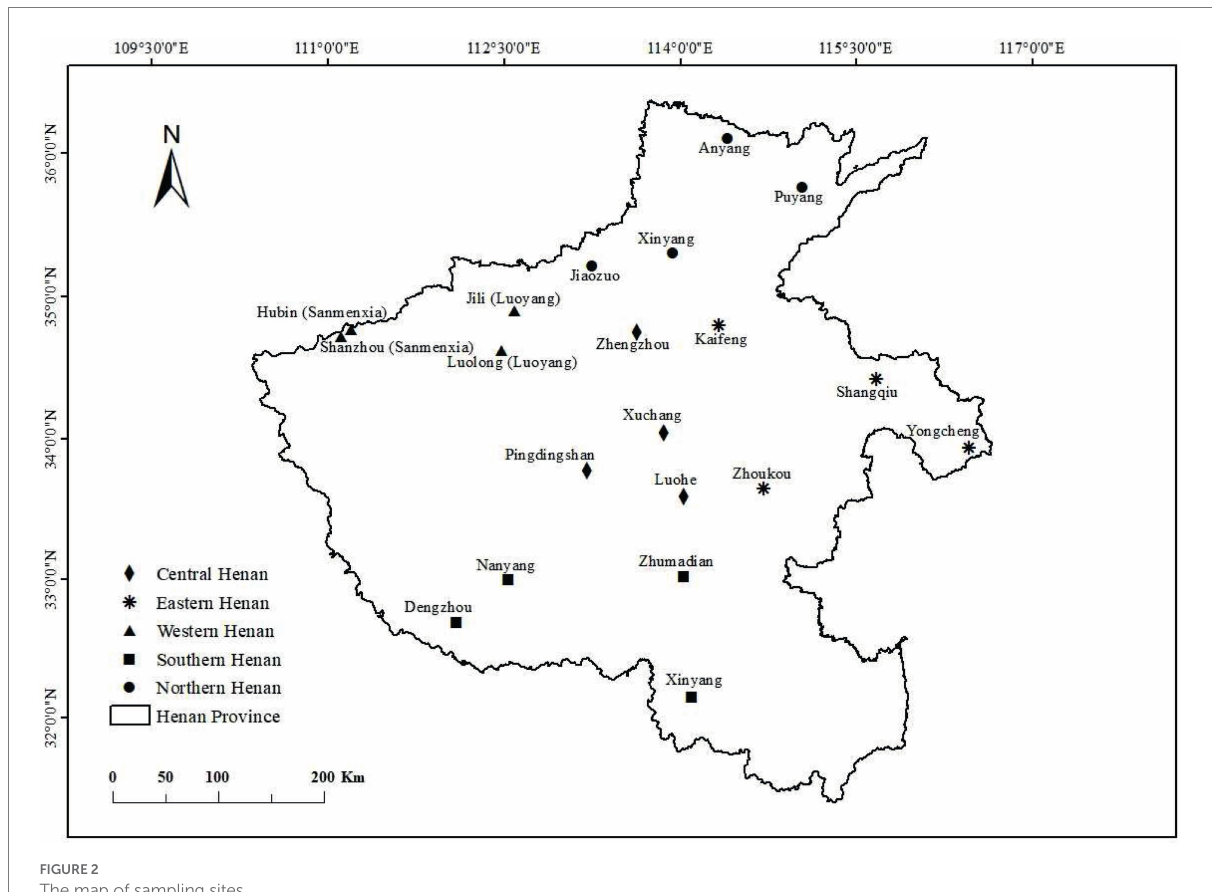
FIGURE 2 The map of sampling sites.